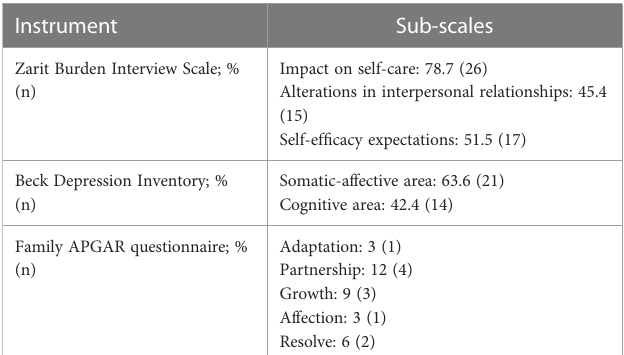
TABLE 3 Sub-scales of the Zarit Burden Interview Scale, Beck Depression Inventory and Family APGAR questionnaire affected in burdened caregivers (n =